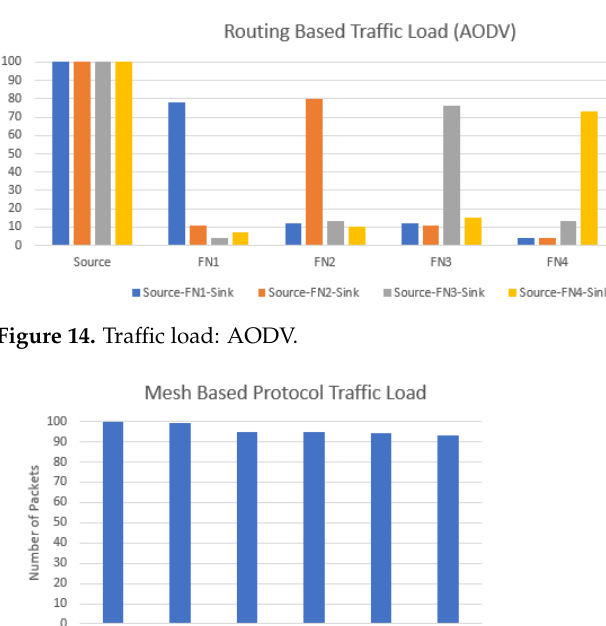
Figure 13. Traffic load: O-AODV.